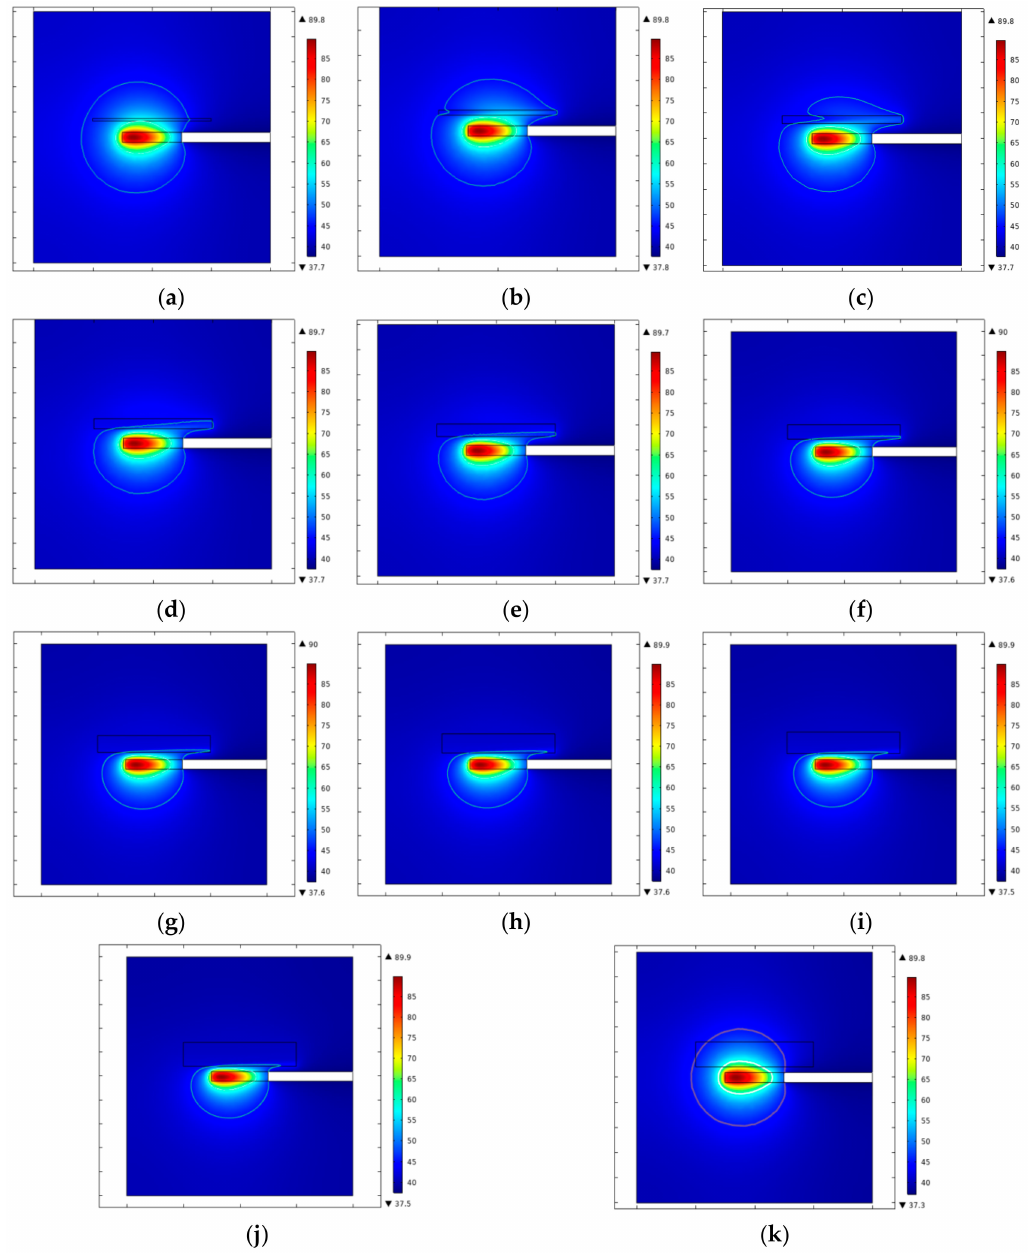
Figure 7. LITT temperature field distribution ( a – j ) indicates the effect of vessels with a radius of 0.1–1.0 mm on the ablation temperature field, ( k ) indicates the temperature field without the effect of vessels, and the green line indicates the loss range. ( a ) r = 0.1 mm, ( b ) r = 0.2 mm, ( c ) r = 0.3 mm, ( d ) r = 0.4 mm, ( e ) r = 0.5 mm, ( f ) r = 0.6 mm, ( g ) r = 0.7 mm, ( h ) r = 0.8 mm, ( i ) r = 0.9 mm, ( j ) r = 1.0 mm, ( k ) No vascular